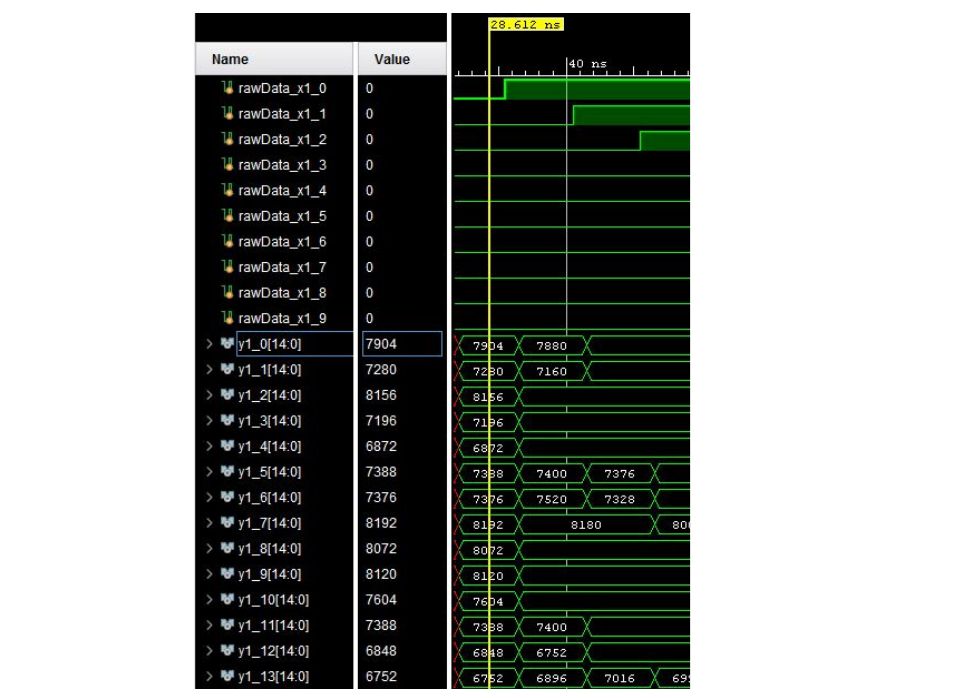
Figure 10. Functioning of the UNC modelled using an Artix-7 FPGA AC701 Evaluation